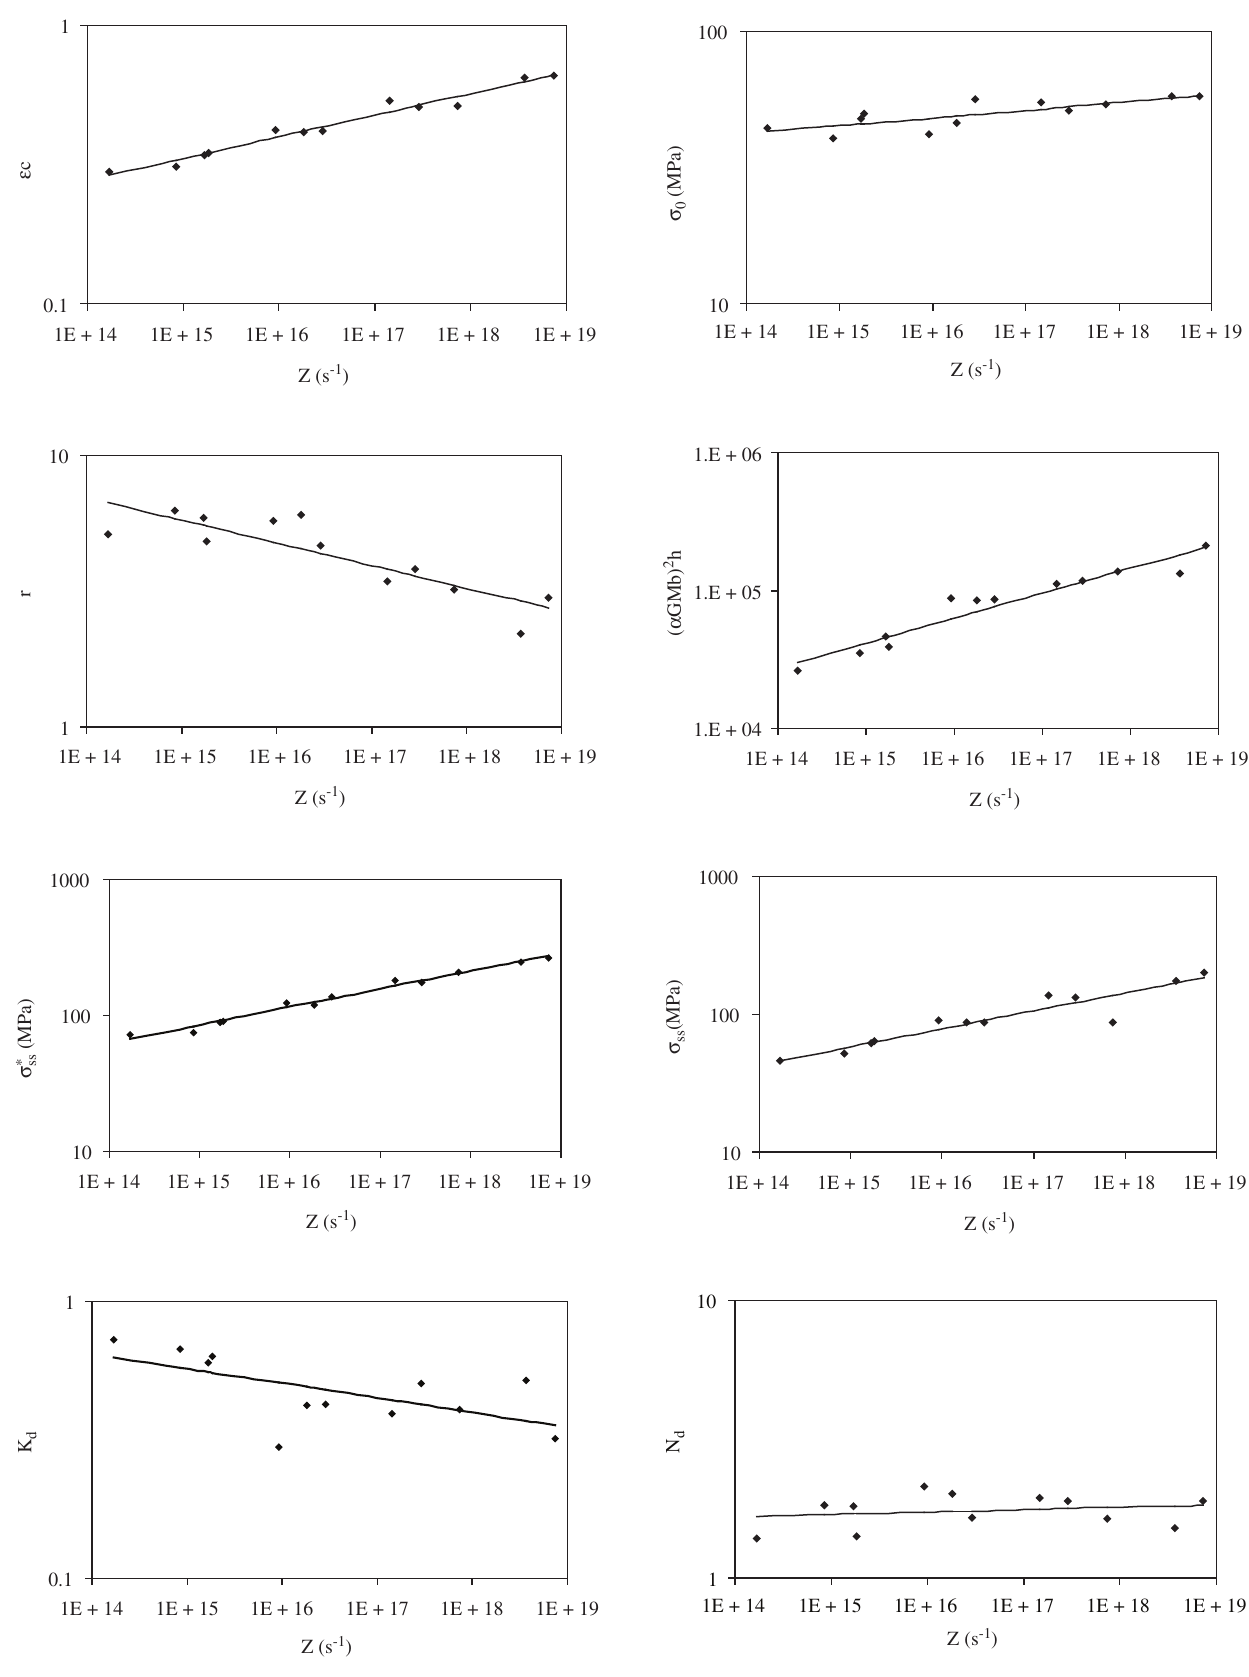
Figure 4. Dependence of the evolution-equation parameters on the deformation